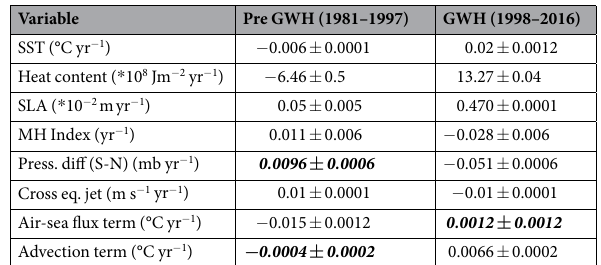
Table 1. Trends and errors for the entire variables used for the present study. The value, which is not significant above 95% CL, is given in bold Italic